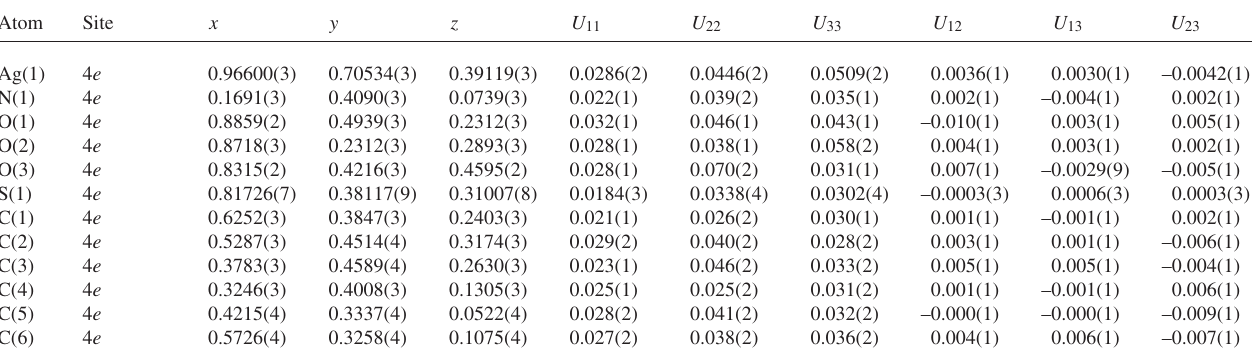
Table 3. Atomic coordinates and displacement parameters (in Å 2 )